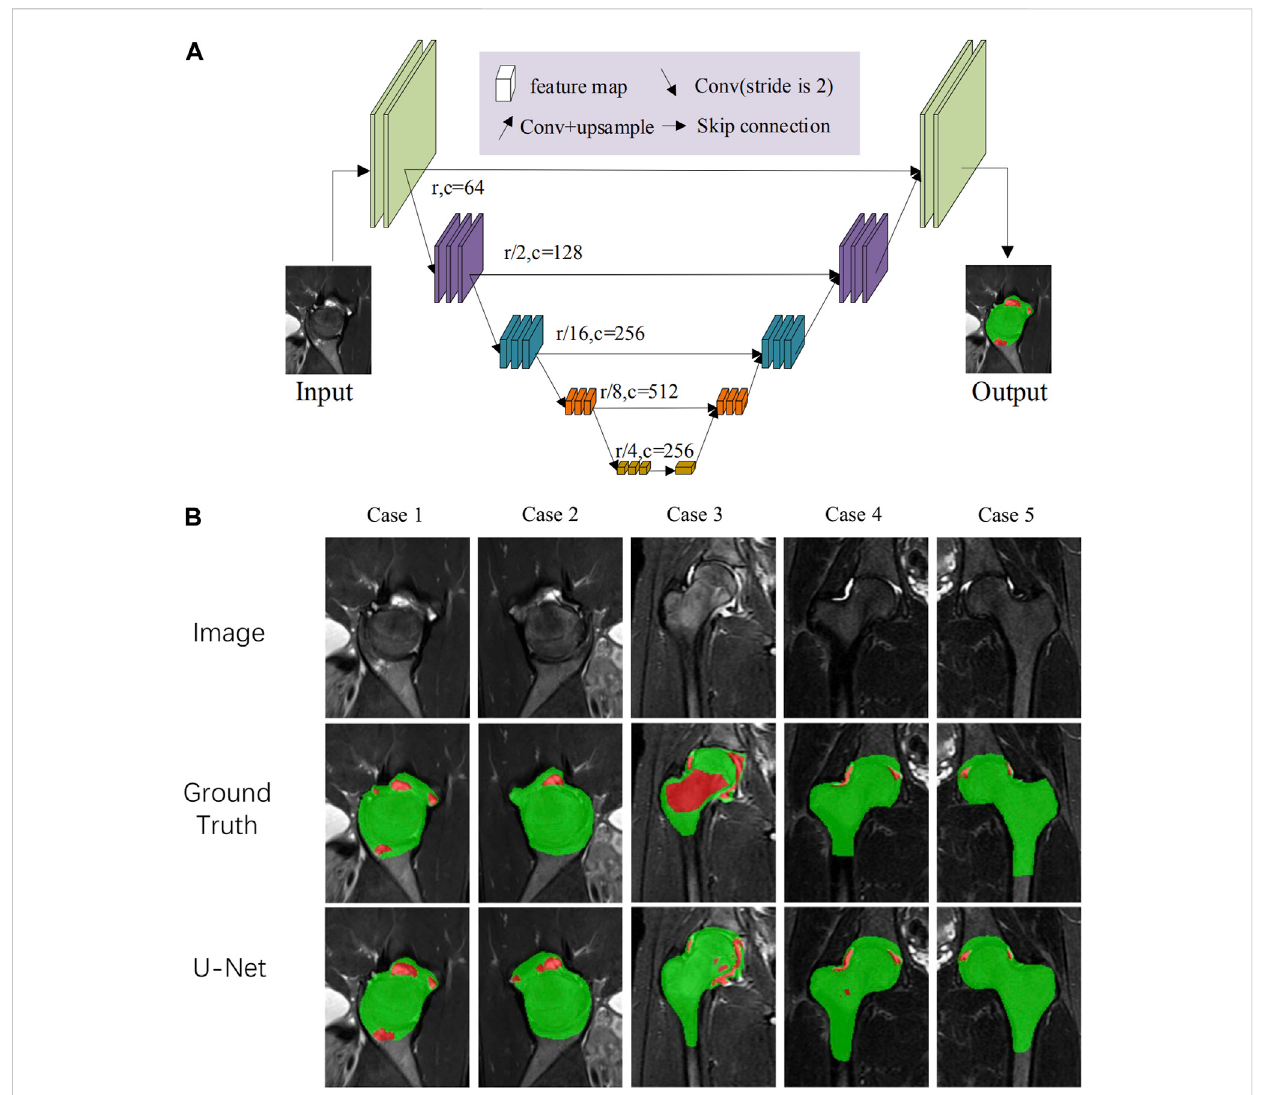
FIGURE 2 (A) The network architecture. U-Net was chosen as the backbone network for rough segmentation and input. The data were fi rst imported to the U-Net network. After downsampling and upsampling, coarse prediction underwent a three-step point rendering, generating pixel-level segmentation. (B) The segmentation and visualized results of the U-Net